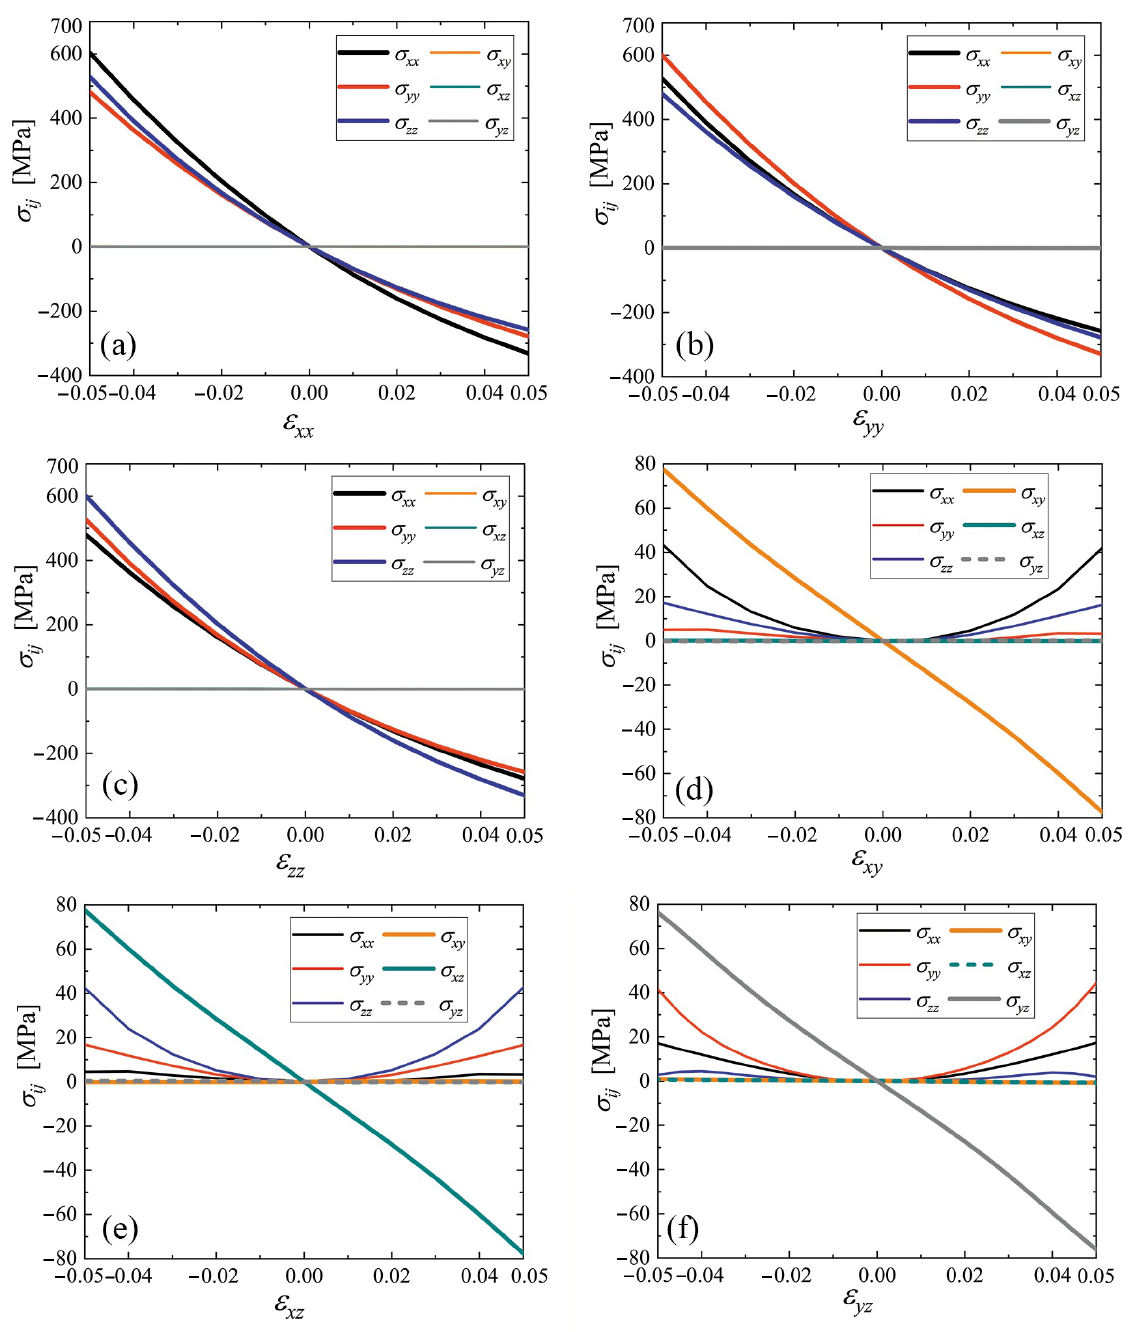
Figure 5. Stress–strain curves for cubic cubene crystal. Only one component of the strain tensor is varied, and the rest are equal to zero. The normal stress components are shown by black ( σ xx ), red ( σ yy ), and blue ( σ zz ) lines. The shear stresses are plotted by yellow ( σ xy ), cyan ( σ xz ), and gray ( σ yz ) lines. In some cases, dashed lines are used to show overlapping curves. Panels ( a – f ) correspond to changing ε xx to ε yz ,